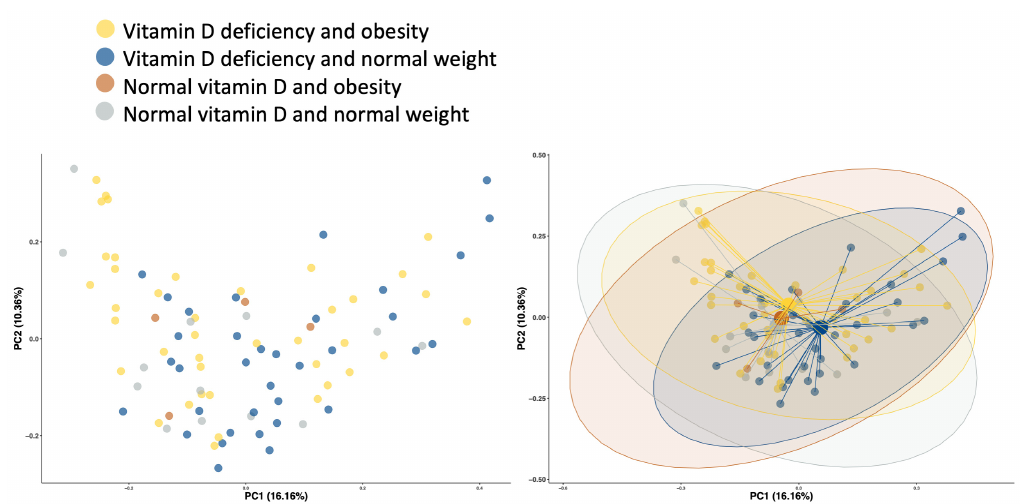
Figure 4. PCoA plot of the Bray–Curtis dissimilarity index.